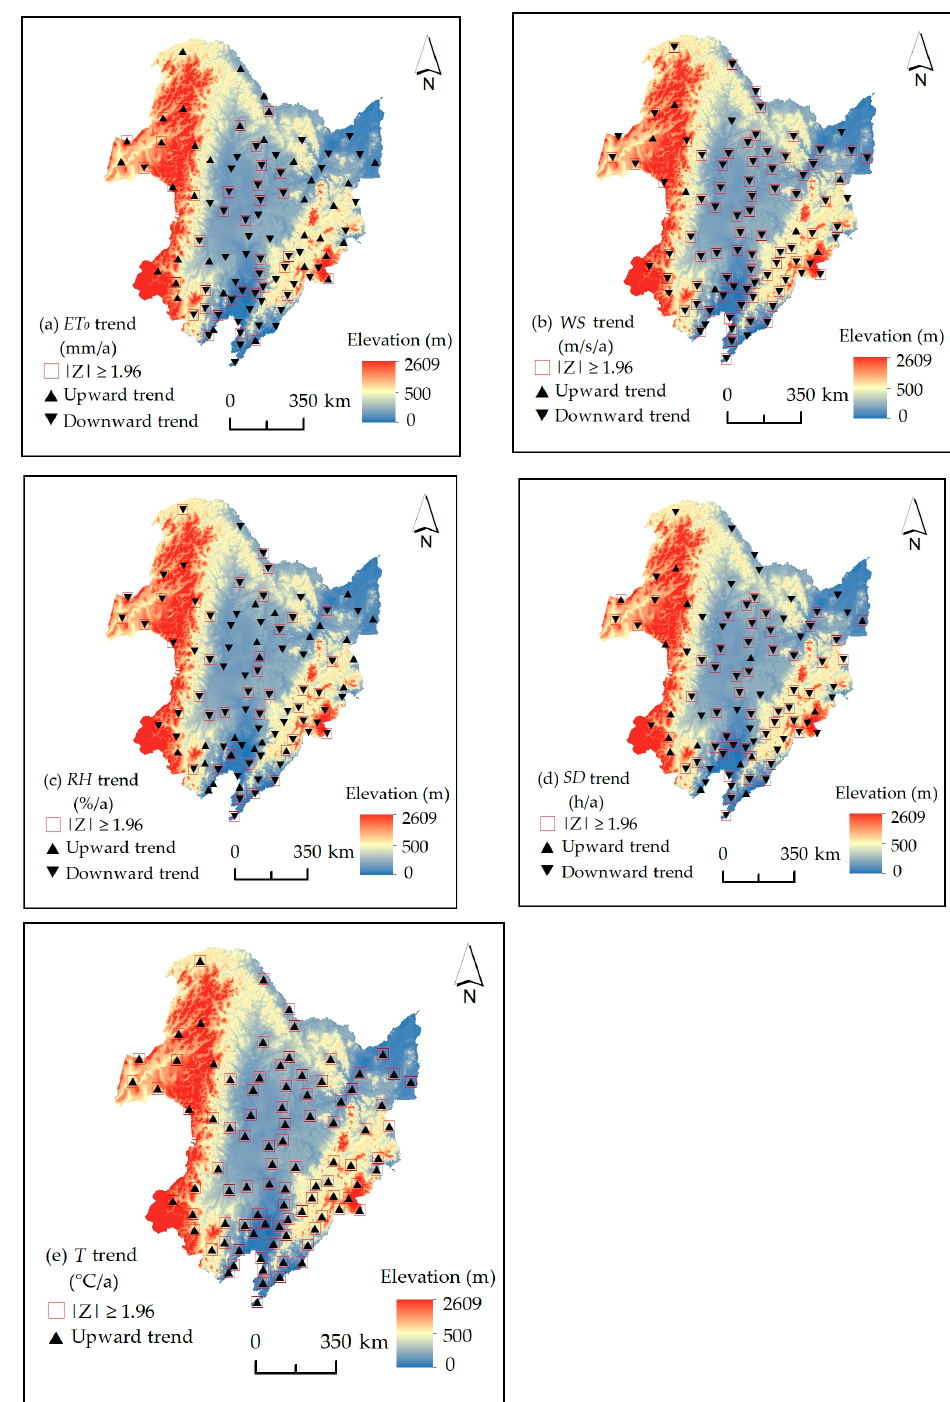
Figure 4. Spatial patterns of trends in ET 0 ( a ), WS ( b ), RH ( c ), SD ( d ), and T ( e ) over Northeast China during the period of 1961–2017. The trends in stations with red squares were significant ( p < 0.05).